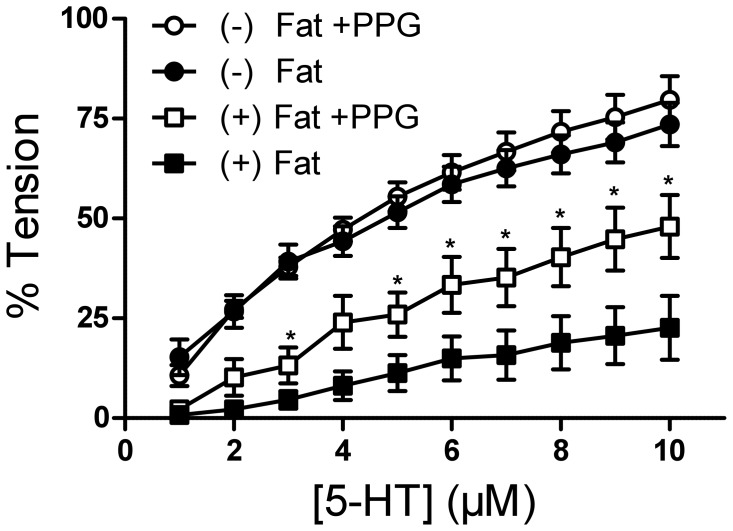
Serotonin (5-HT) dose response curves of rat aortic rings with (Fat (+)) and without (Fat (−)) perivascular fat with and without preincubation with PPG (30 min, 10 mmol/l) in Mulvany Small Vessel Myograph.* p<0.05. n = 7 in (−) Fat rings. n = 6 in (+) Fat rings.